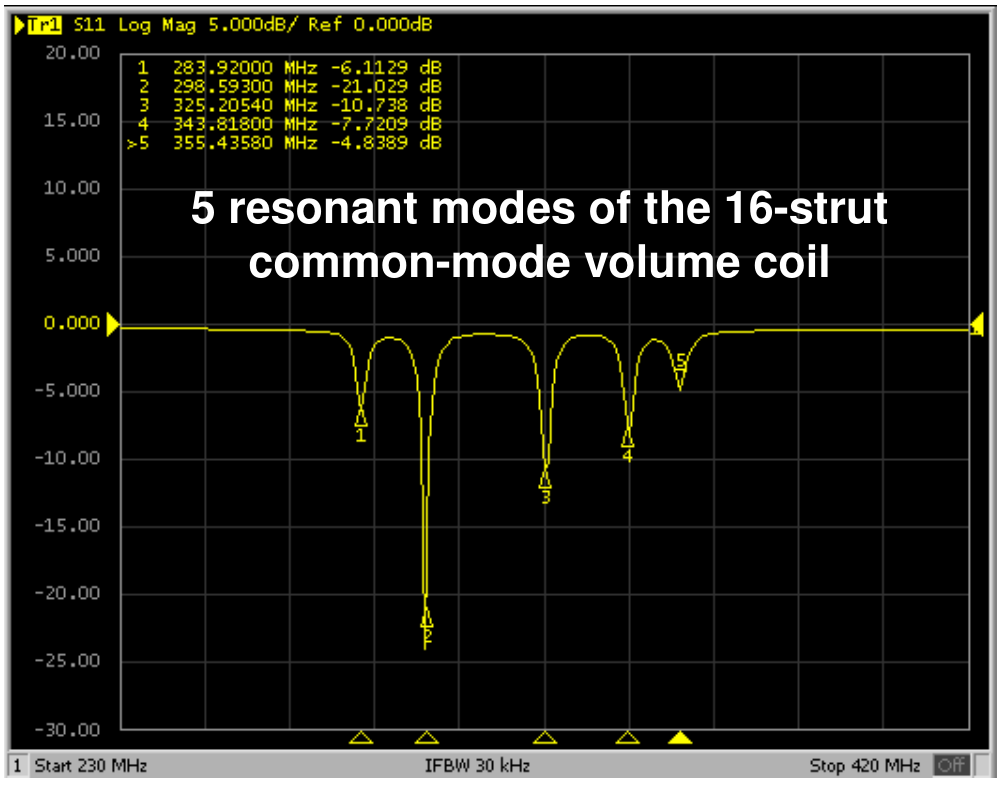
Figure 3. Bench measurement result of reflection coefficient S11 plot of the 16-strut common-mode volume coil. 5 well defined resonant modes can be clearly observed from the picture showing reduction in resonant modes, while a conventional 16-strut volume coil normally has 9 resonant modes (or 8 modes for regular birdcage coil).